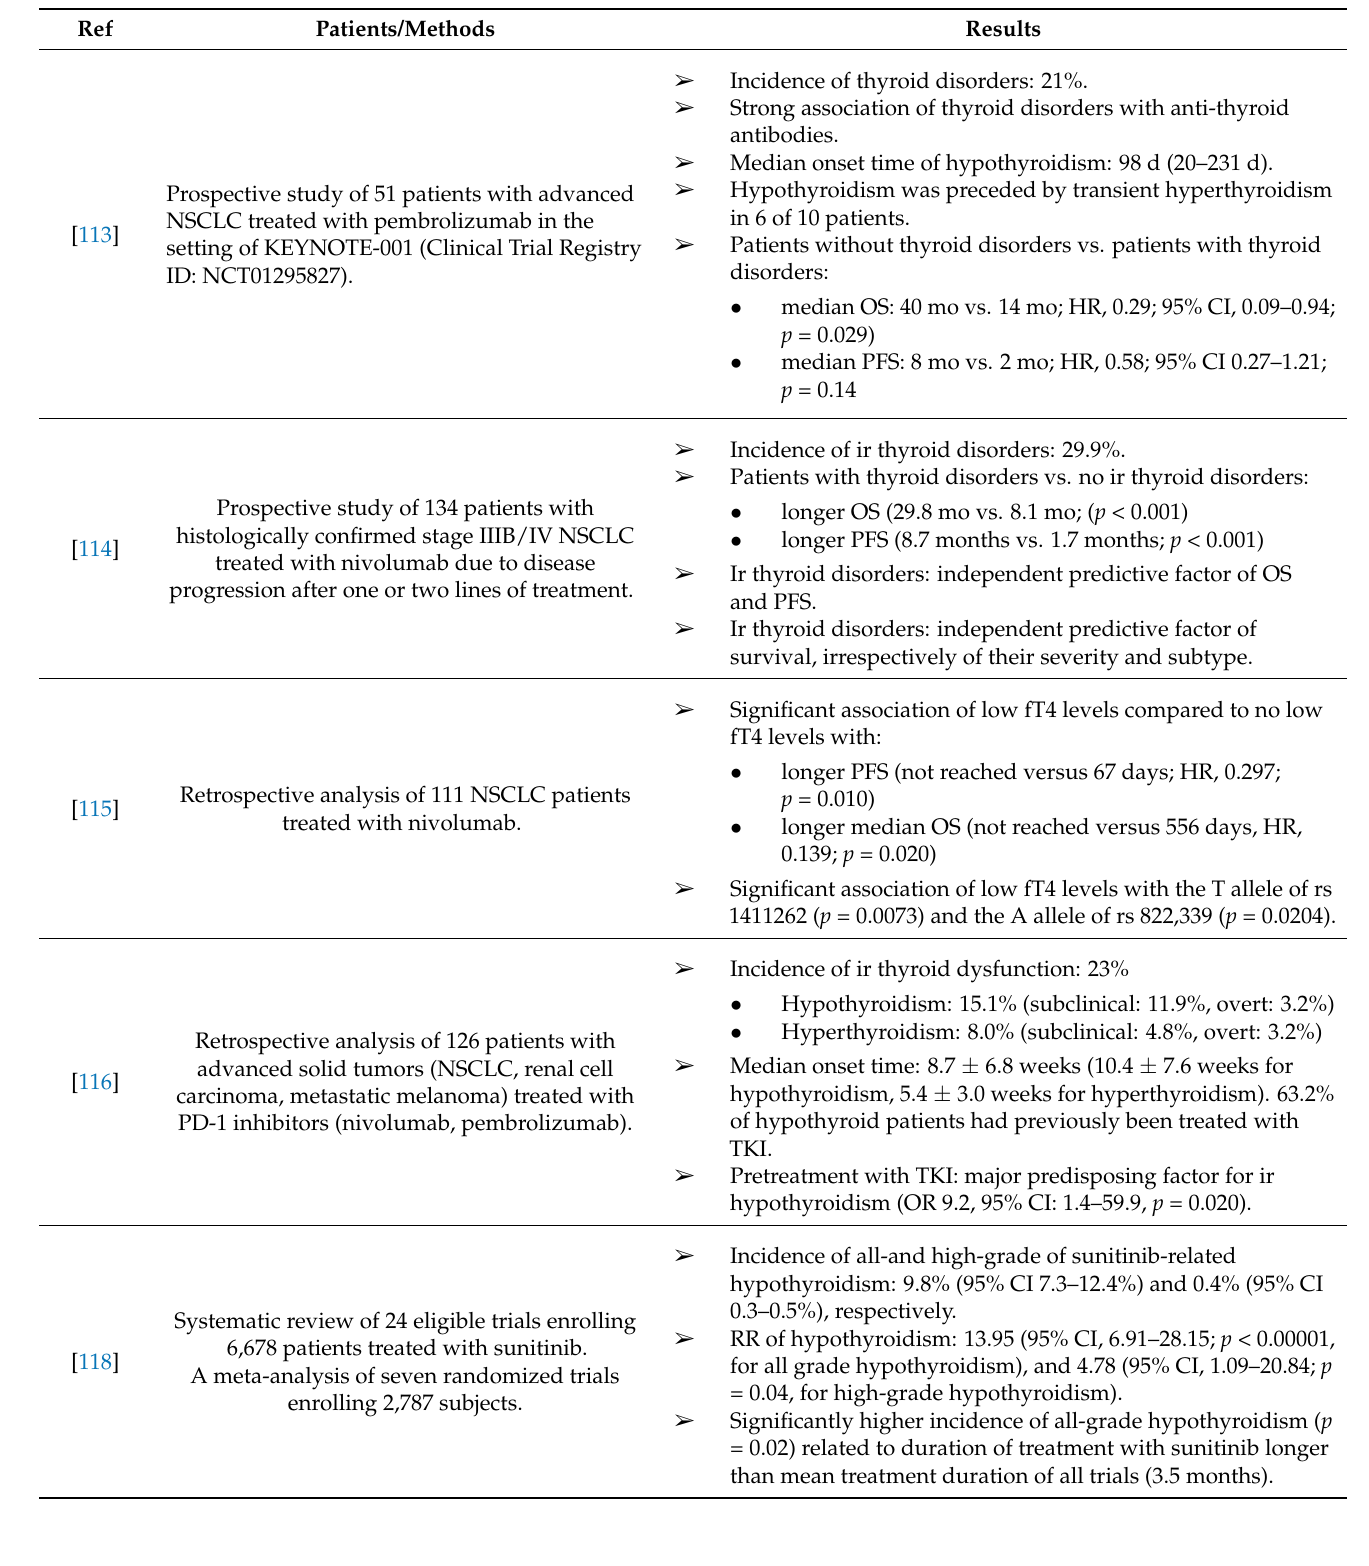
Table 4. Representative studies addressing the thyroid disorders related to ICPi and TKI in lung cancer